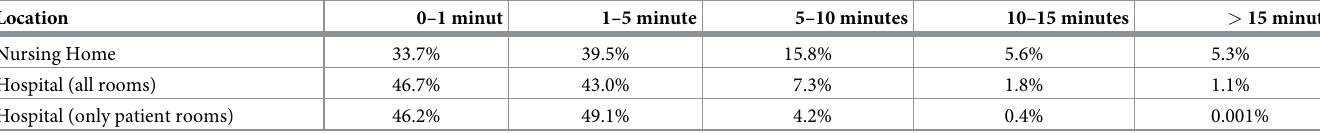
Table 1. Overview of the duration of the different observations at the different locations. Not accumulated. Location